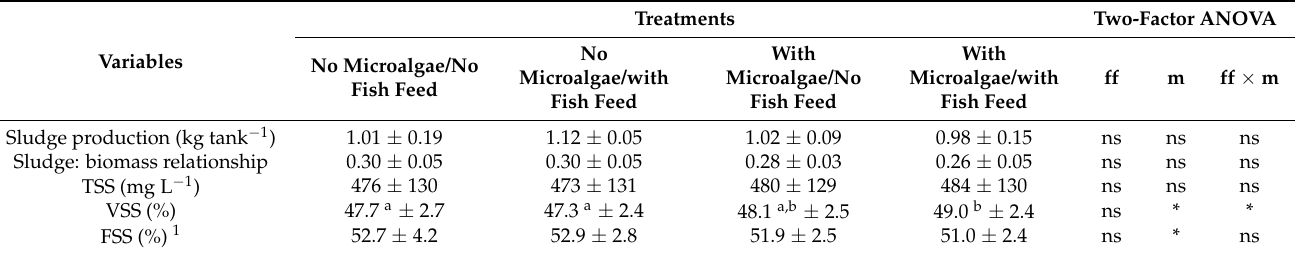
Table 5. Sludge production of a Pacific white shrimp ( Litopenaeus vannamei ) and Nile tilapia ( Ore- ochromis niloticus ) integrated system using biofloc technology which was carried out during 62 days, evaluating the addition of microalgae and fish feed in a factorial design.